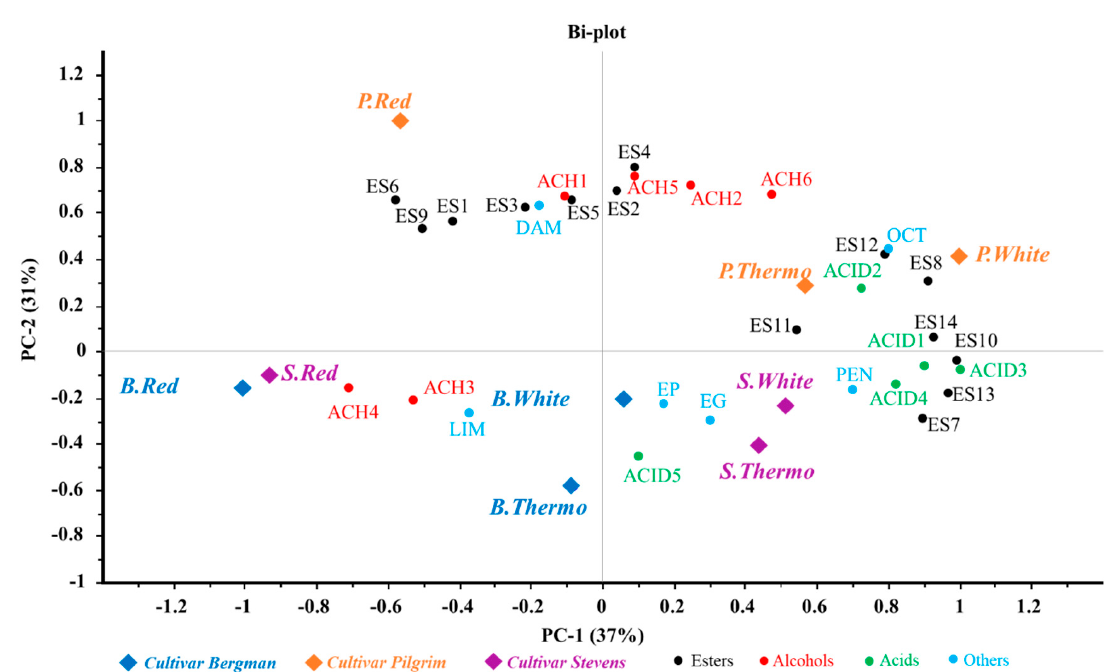
Figure 3. Principle component analysis (PCA) volatile compounds in cranberry wines. ACH: alcohol; LIM: D-Limonene; ES: ester; DAM: β -damascenone; EP: 4-ethylphenol; EG: 4-ethylguaiacol; OCT: 3-Octanone; PEN: Pentanal.